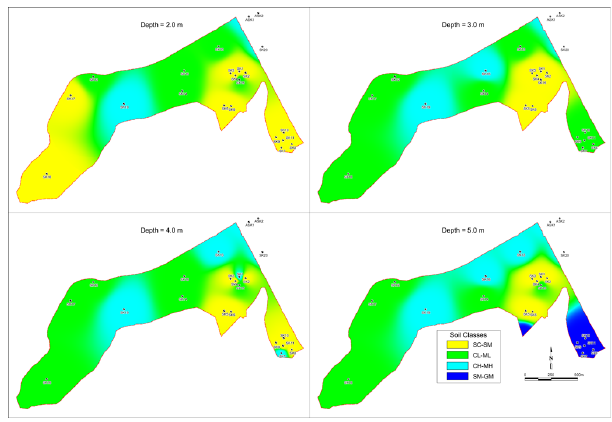
Fig. 8. Soil class zonation maps of the study area.